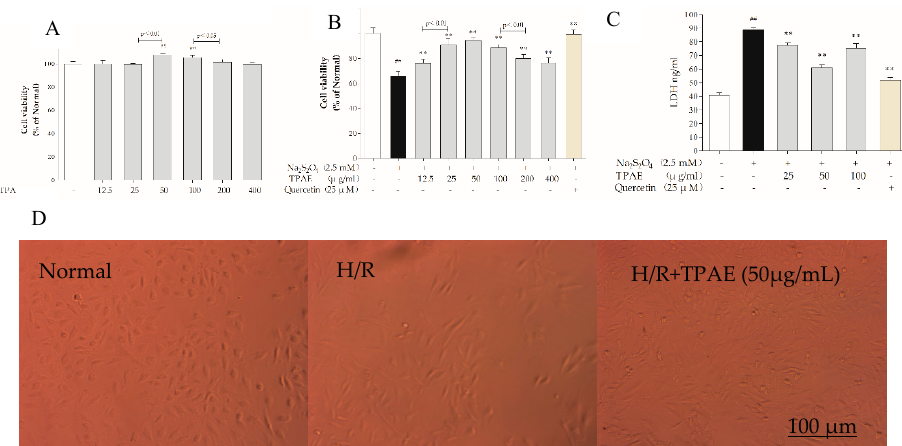
Figure 1. Effects of TPAE on H/R induced H9c2 cell death and morphological changes. H9c2 cells were pretreated with various concentrations of TPAE for 24 h followed by 30 min of hypoxia and 4 h of reoxygenation or only pretreated with various concentrations of TPAE for 24 h. ( A ) Cytotoxicity was detected by MTT assay; ( B ) Cell viability was determined by MTT assay; ( C ) LDH release was measured by ELISA kit; ( D ) Morphology alterations after H/R injury under an inverted phase microscope. Values were represented as mean ± SD (n = 6 for MTT, n = 8 for ELISA, each group). The results were representative of three independent experiments. # p < 0.05, ## p < 0.05 vs. normal group; * p <